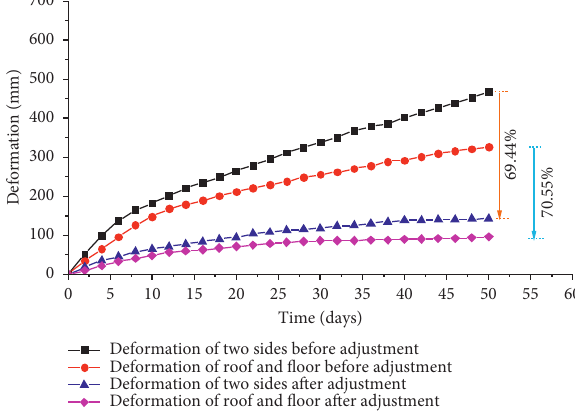
Figure 18: The roadway formation with different support